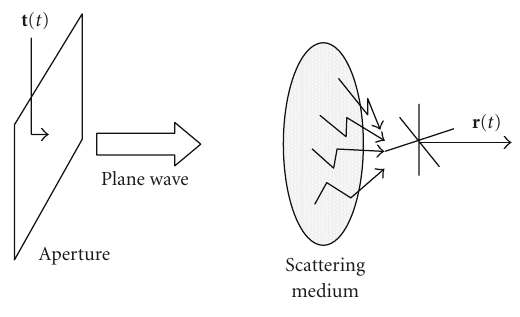
Figure 6: A satellite-to-mobile/indoor link.